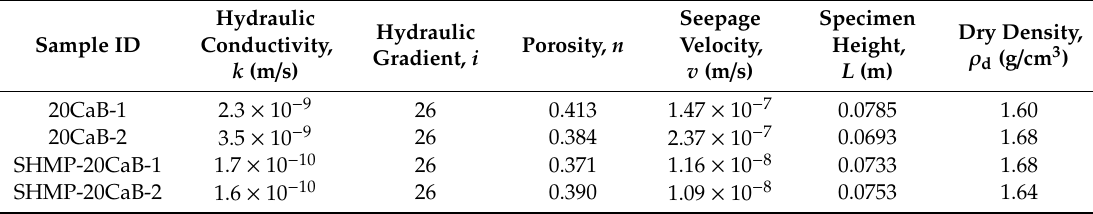
Figure 2. Hydraulic conductivities of the ( a ) unamended backfill (20CaB), and ( b ) amended backfill (SHMP-20CaB). Table 1. Summary of final parameters of specimen after flexible wall hydraulic conductivity tests.